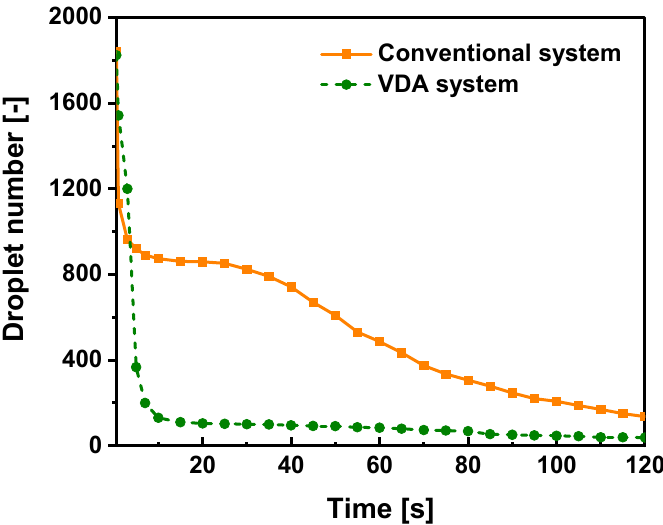
Figure 11. Variation in the droplet number in the conventional and VDA systems according to the time after coughing.